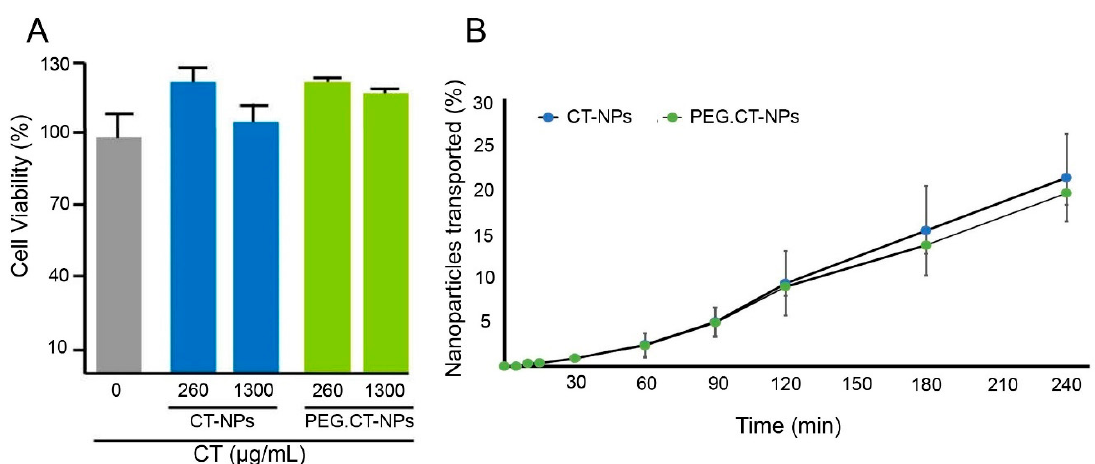
Figure 1. ( A ) Caco-2 cell viability upon exposure to different concentrations of CT-NPs and PEG.CT-NPs, as determined by the MTT (3-(4,5-dimethylthiazol-2-yl)-2,5-diphenyltetrazolium bromide solution) assay and ( B ) cumulative transport of CT-NPs and PEG.CT-NPs across Caco-2 cell monolayers. Values are expressed as the mean ± standard deviation (S.D.).